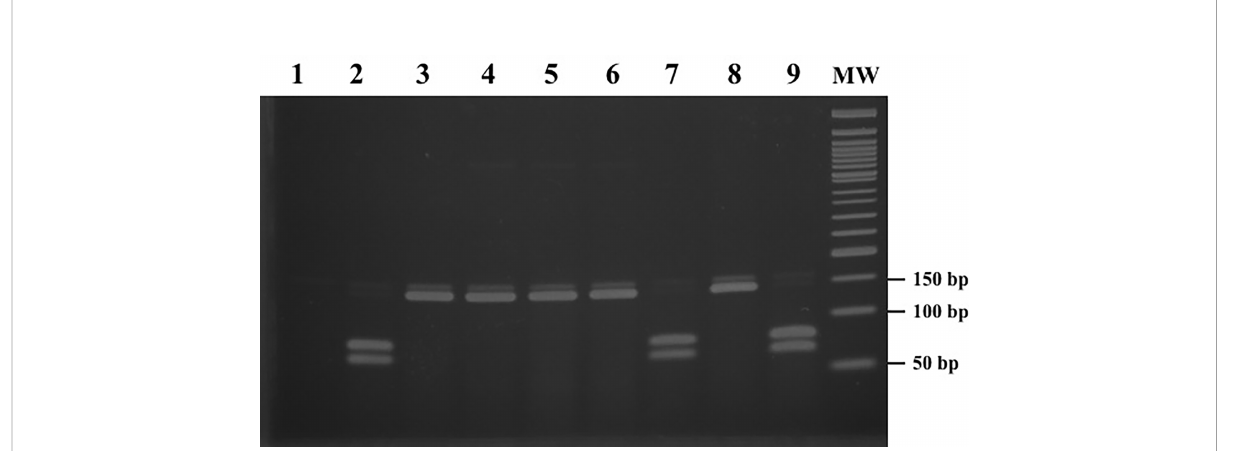
FIGURE 2 PCR-RFLP patterns obtained after digestion with Aci I for gyrA . Lane 1: negative control; lanes 2, 7, and 9: isolates with wild-type gyrA ; lanes 3-6: 91 codon ACC ! ATT; lane 8: 91 codon ACC ! ATC; lane MW: 50 bp ladder molecular-mass